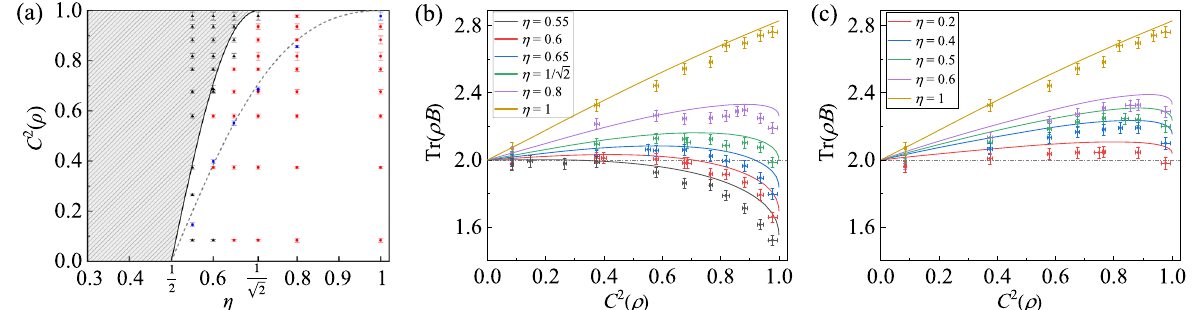
Fig. 2 Experimental results for the fi rst and second scenarios. a Squared concurrence of the state C 2 ( ρ ) versus the detection ef fi ciency of Bob ’ s noisy measurement η . For a given η , a state with the squared concurrence at or above the solid curve (the shaded area) will never violate the CHSH inequality. For η > 1/2, there is always a state violating the CHSH inequality maximally and the squared concurrence of the state is ffiffiffi p 2 given by the dashed curve. For η (cid:7) 1 = , no maximally entangled states ( C 2 = 1) can violate the CHSH inequality. In our experiment, more ffiffiffi ffiffiffi p (cid:6) (cid:7) p 2 2 values of η in 1 = 2 ; 1 = are chosen to manifest the behavior around η ¼ 1 = . Black triangles denote the squared concurrence of the states which do not violate the CHSH inequality for a given η . Red dots denote C 2 of the states which violate the CHSH inequality. Blue squares denote C 2 of the states which violate the CHSH inequality maximally. b Violations of the CHSH inequality versus the squared concurrences of the states for various detection ef fi ciency η . For η < 1, more nonlocality with less entanglement is observed. c Violations of the CHSH inequality versus the squared concurrences of the states for the second scenario, where only one of Bob ’ s measurement choices is inef fi cient. The CHSH inequality can be violated for an arbitrary η > 0. To show the difference between the fi rst and second scenarios, we choose more values of η in 0 ; 1 = 2 ½ (cid:4) . Error bars indicate the statistical uncertainty which is obtained based on assuming Poissonian